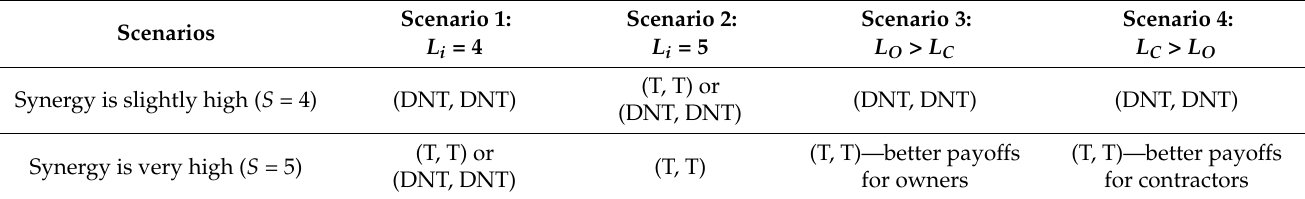
Table 10. Optimal decisions for each scenario in large and complex